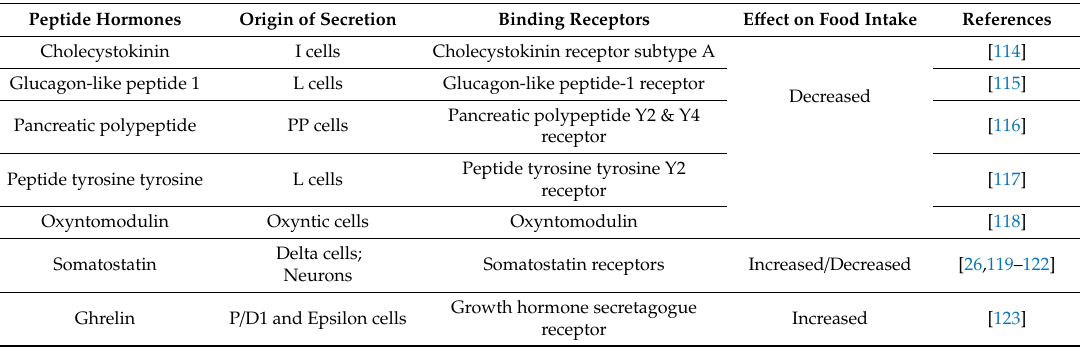
Table 1. The summary of the e ff ects of gastrointestinal hormones on food